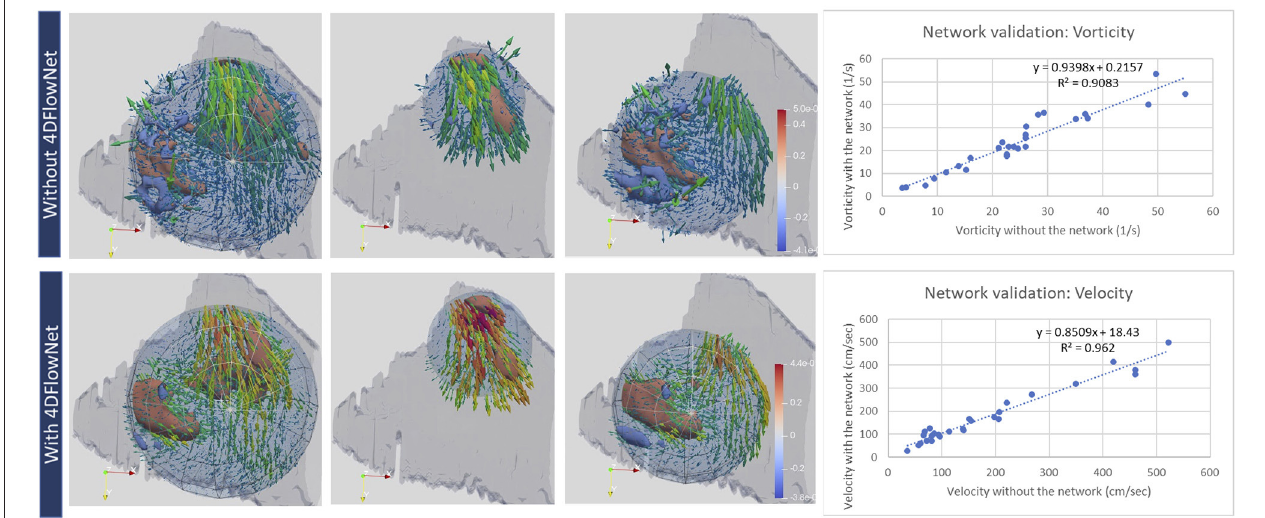
FIGURE 2 | Qualitative (left) and quantitative (right) evaluation of velocity and vorticity with and without the 4DFlownet. The panels show the 3 regions of interest where vorticity was captured (left: whole RV; middle: RVOT; right: tricuspid inflow in diastole. The network reduced noise making the vorticity structure more readily visualized. Right plots show mean vorticity calculated in the region of interest and mean velocity calculated at planes positioned in the RVOT, showing high correlation before and after 4DFlowNet.